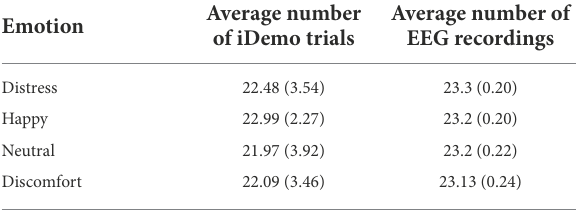
TABLE 4 Average number of observations per participant per iDemo administration. Average number Emotion of iDemo